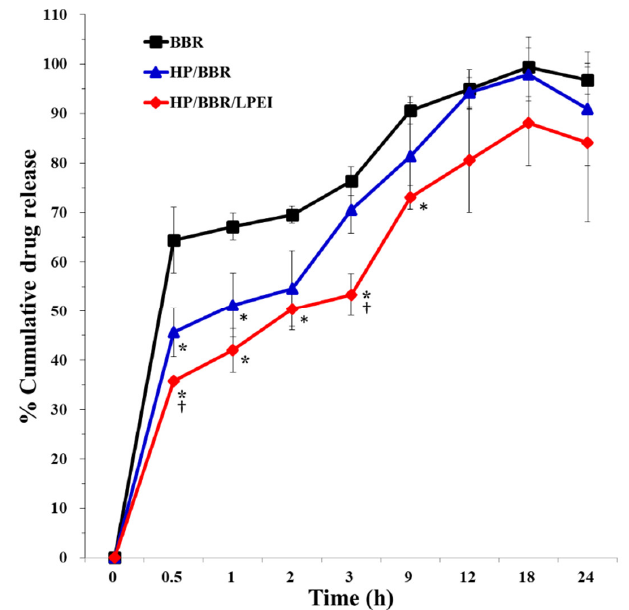
Figure 2. The release profiles of BBR solution and BBR NPs (HP/BBR or HP/BBR/LPEI NPs) for 24 h. * p < 0.05 significant difference between BBR-treated groups and the control and † p < 0.05 significant difference between HP/BBR-treated groups and HP/BBR/LPEI groups as analyzed by one-way ANOVA with post hoc Tukey HSD (Honest Significant Difference).